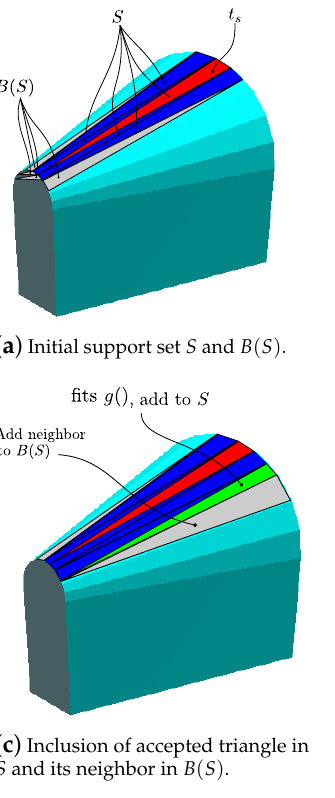
Figure 18. Step-wise execution of the S extraction g () fitting algorithm, applied to a cone which does not accept S extraction based on dihedral angles.